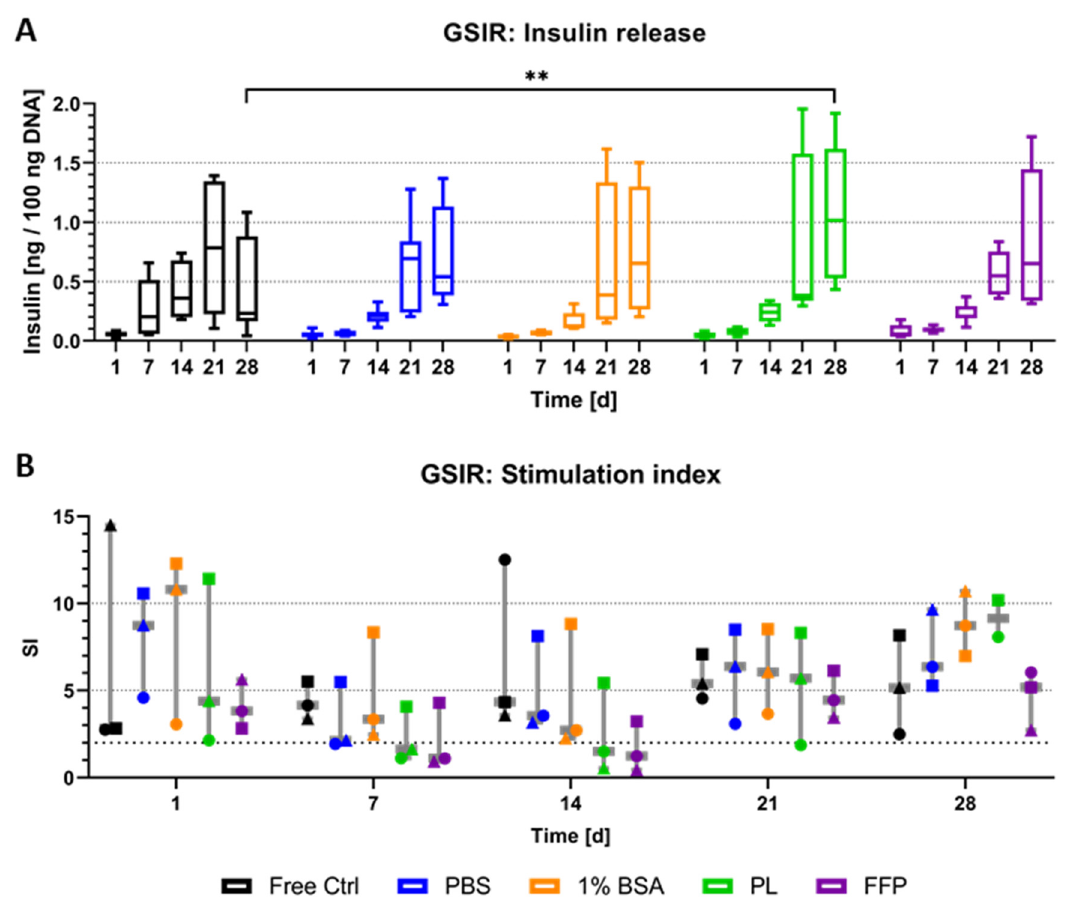
Figure 6. Glucose-stimulated insulin release of NICC. Analysed groups are free control NICC in suspension culture and NICC bioprinted in PBS-algMC, BSA-algMC, PL-algMC, and FFP-algMC. ( A ) Amount of insulin released in response to stimulation with high (16.4 mM) glucose normalised to 100 ng DNA. Mean ± SD, n = 9 replicate values from 3 replicate exp., significances indicate ** p < 0.01. ( B ) Stimulation index as ratio of insulin released during stimulation with high (16.4 mM) and low (3.3 mM) glucose. Mean ± SD, n = 3 exp., 3 replicates each, the 3 different experiments are dis-tinguished by different symbols.